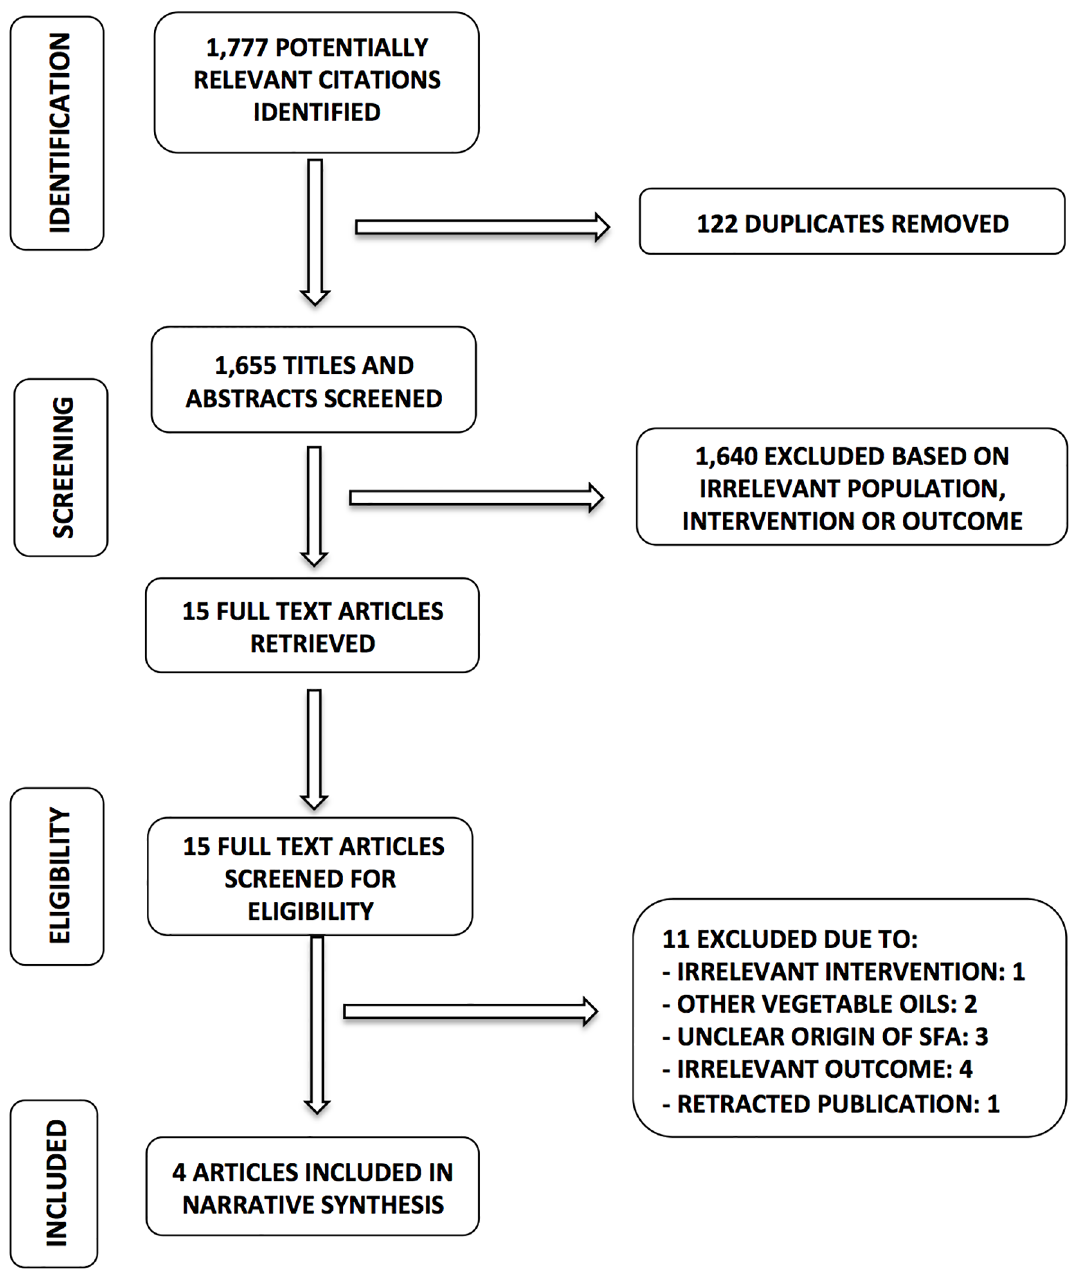
Fig 1. PRISMA flowchart of association of palm oil consumption and coronary heart disease. SFA: Saturated fatty acids.